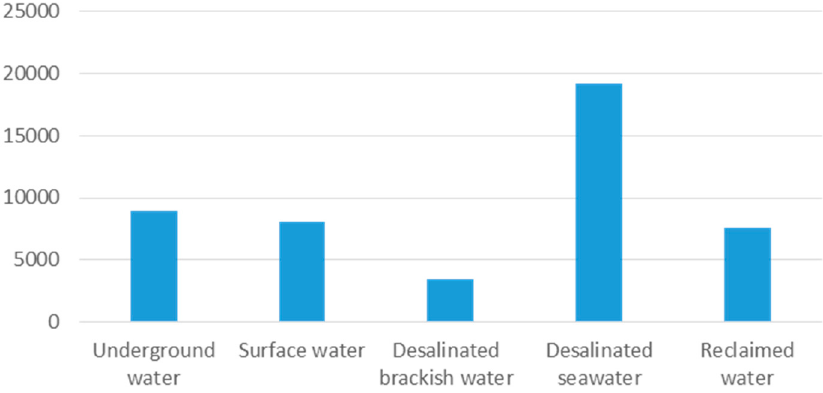
Figure 8. Consumption (m 3 ha − 1 year − 1 ) per water typology in the studied area.